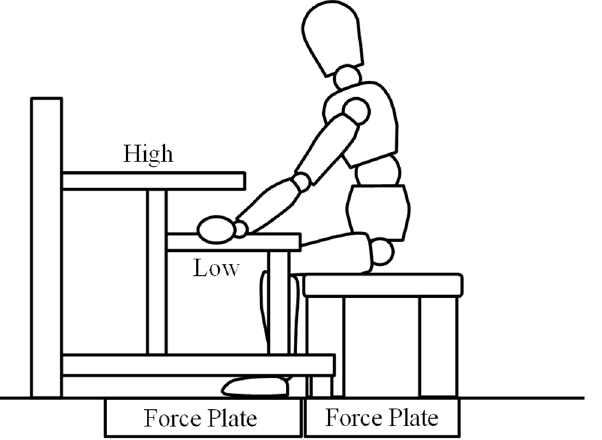
Fig 1. Schematic drawing of the motion analysis for young adults during STS movement with and without handrail support. The FRF of the bilateral lower extremity and chair were measured using three force plates, respectively. The height of the handrails was adjusted to the greater trochanter in the standing position (High) or the sitting position (Low), bilaterally.